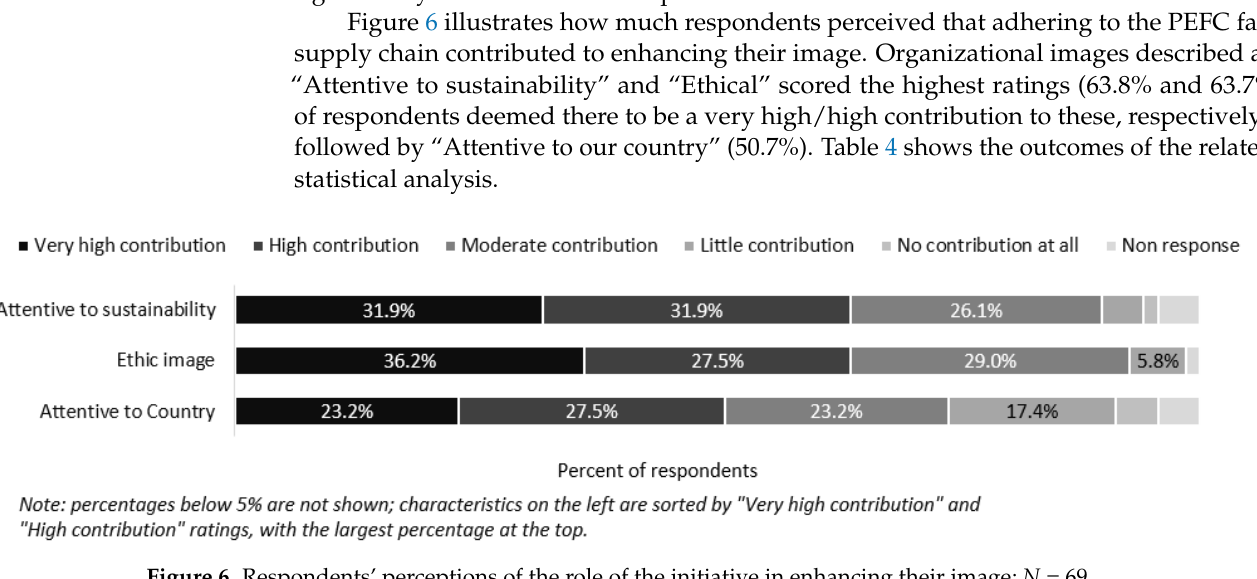
Figure 6. Respondents’ perceptions of the role of the initiative in enhancing their image; N = 69. Table 4. Respondents’ perceptions of the role of the initiative in enhancing their image. Goodness of fit test: Comparison of grouped responses from all respondents with expected uniform distributions of responses. Fischer exact test: Associations between organizations’ categories and reasons’ ratings. Significance set at a level of